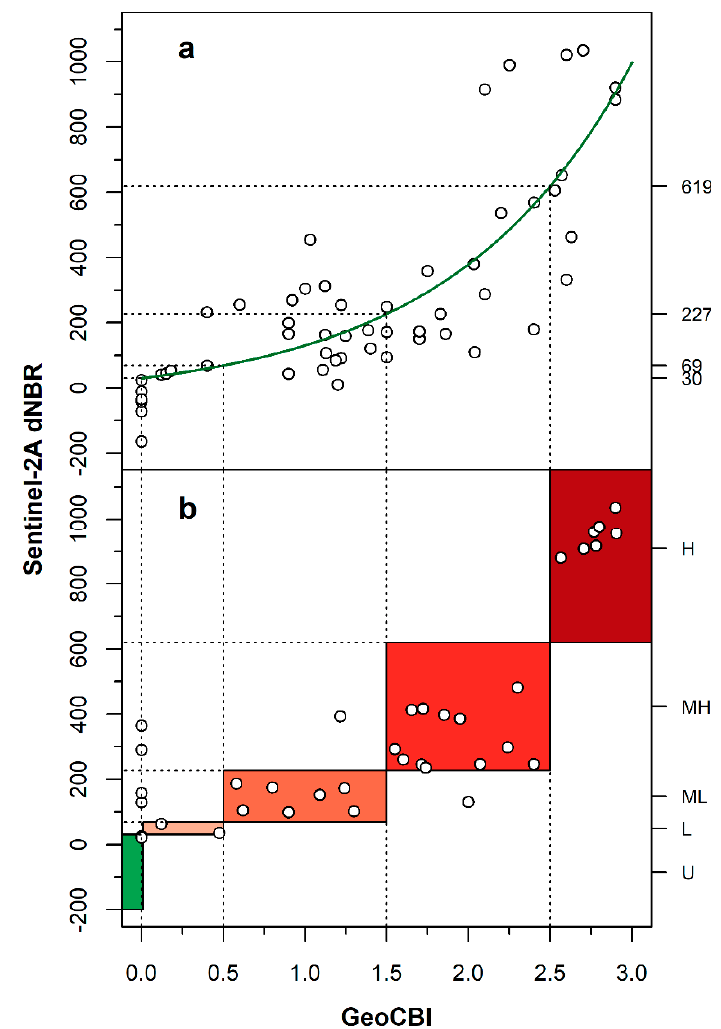
Figure 3. Relationships between the field-based Geometrically Composite Burn Index (GeoCBI) and satellite-based differentiated Normalized Burn Ratio (dNBR) derived from the Sentinel 2A remote sensor. In ( a ) the green line represents the non-linear regression model estimated on the training dataset (n = 54 field plots). The left axis reports the regressed values of the dNBR thresholds. In ( b ) white circles represent the validation dataset (n = 36 field plots). Colored square boxes from dark red to green and the codes reported on the left axis H, MH, ML, L, and U correspond respectively to the following burn severity classes: High, Moderate-high, Moderate-low, Low, and Unburnt. In ( a ) and ( b ) dotted vertical and horizontal lines correspond to field-based GeoCBI and satellite-derived dNBR burn severity thresholds, respectively.